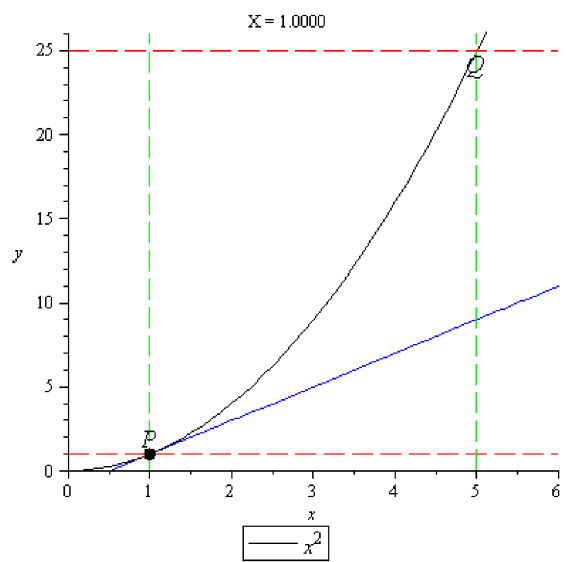
Figure 2. Geometry Representation of the Tangent Line on a